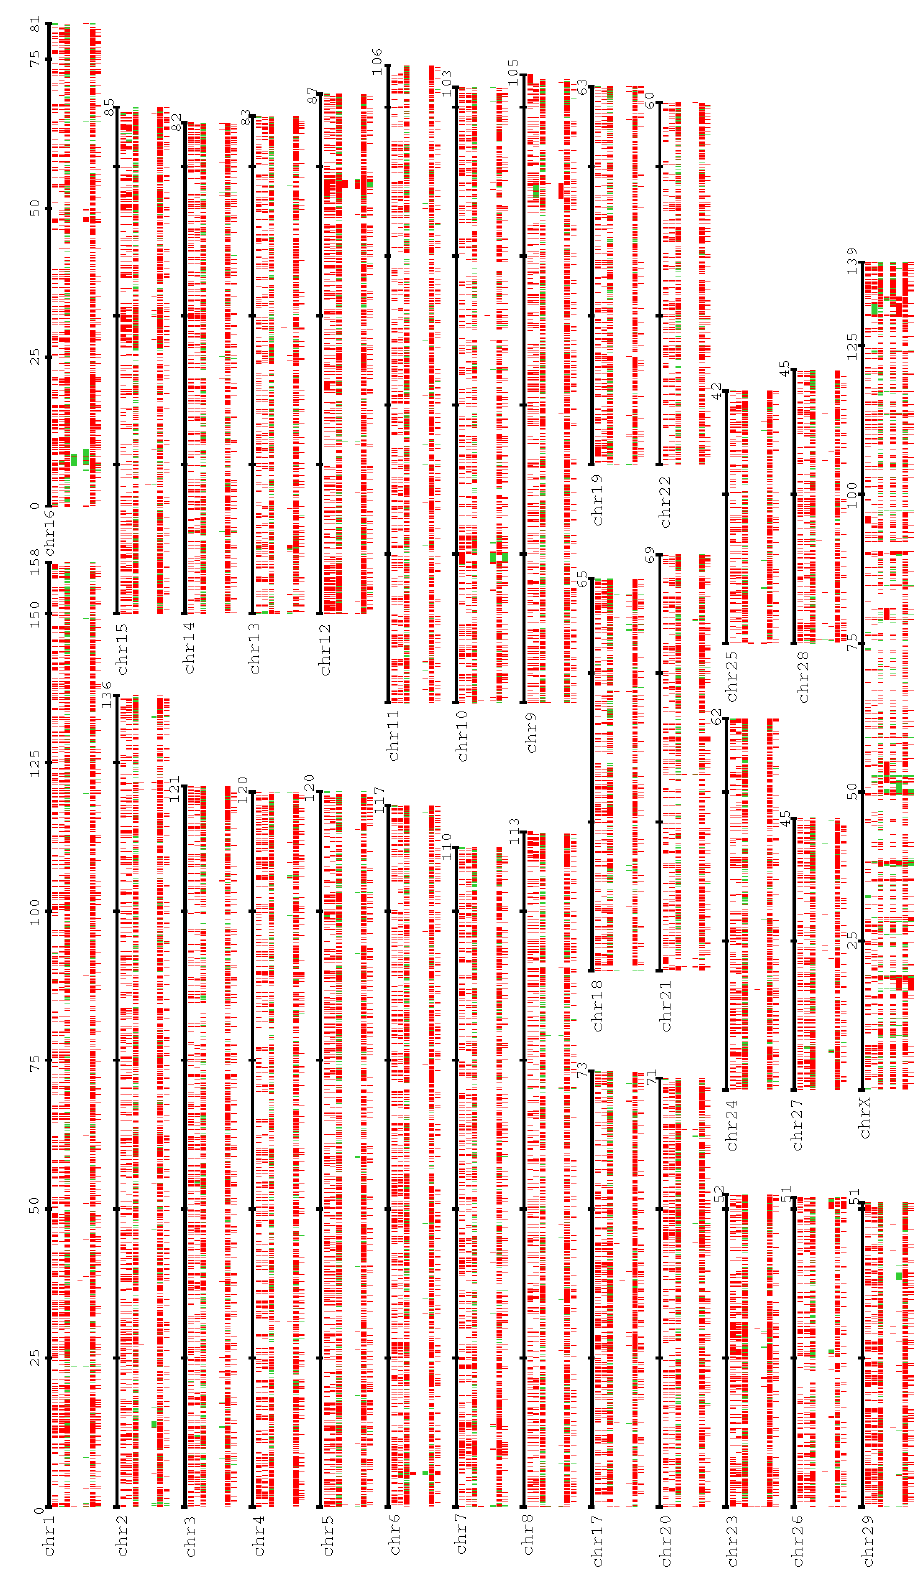
Figure 2. Individualized cattle SV map. The tracks under every black bar represent the SVs for 10 × G_LongRanger, 10 × G_LinkedSV, CCS_PBSV, CCS_Sniffles, CLR_PBSV, CLR_Sniffles, ONT_PBSV and ONT_Sniffles (in order from top to bottom). Red means deletion, and green means